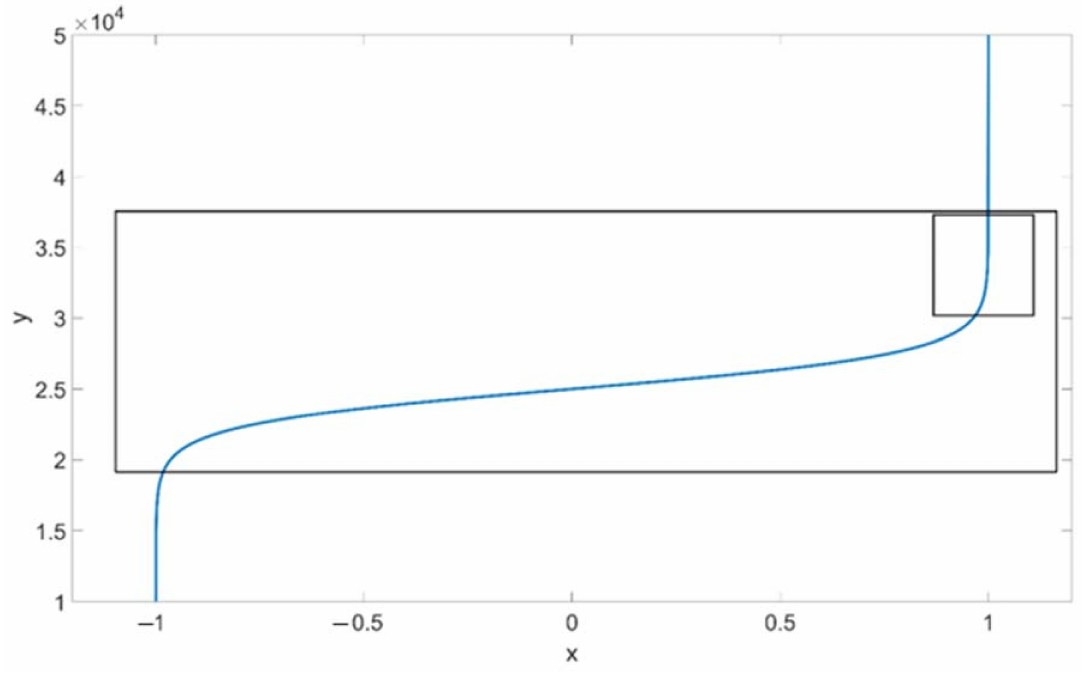
Figure 4. Hyperbolic tangent function; the large rectangle shows the curve range selection for the N ( h ) profile shape of the E layer. The square shows the variation interval of the variables for the model function of the E s layer